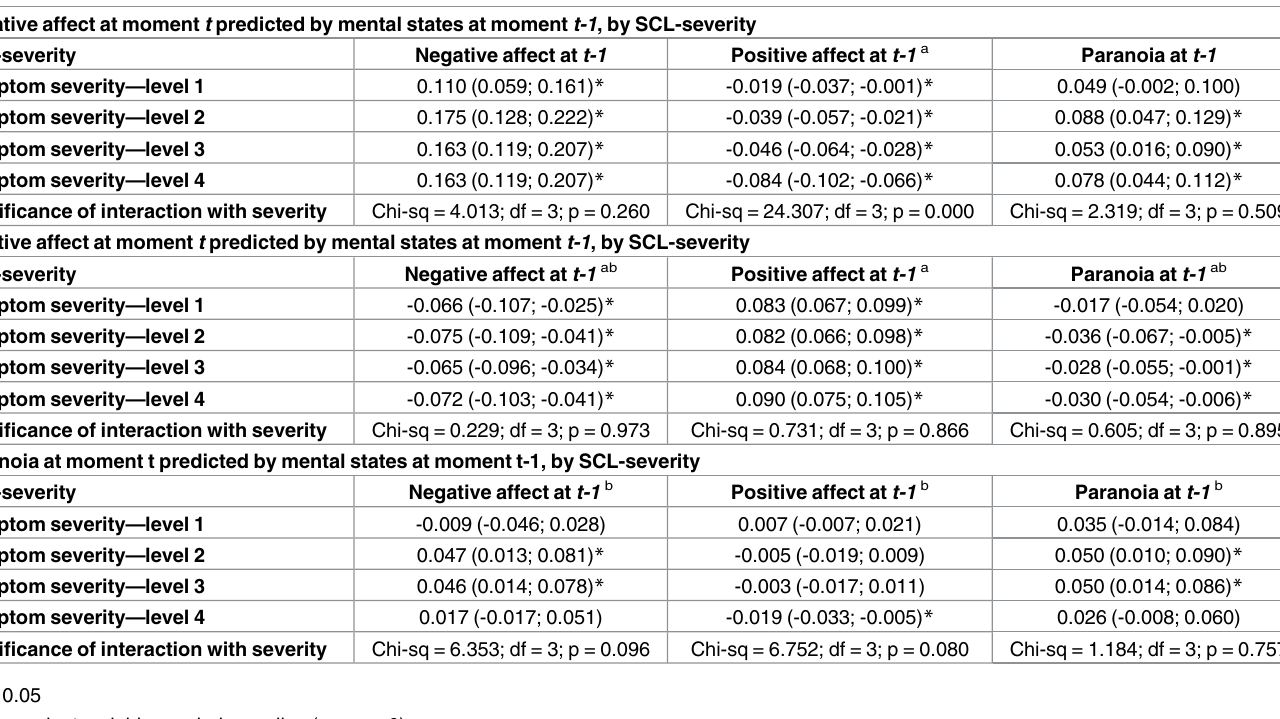
Table 3. Mental states (negative affect, positive affect and paranoia) at moment t predicted by mental states at moment t-1 , by SCL-severity. Method: inverse Gaussian regressionanalysis. Subgroup-specific regression(B) coefficients with 95% confidence intervals. Negative affect at moment t predicted by mental states at moment t-1 , by